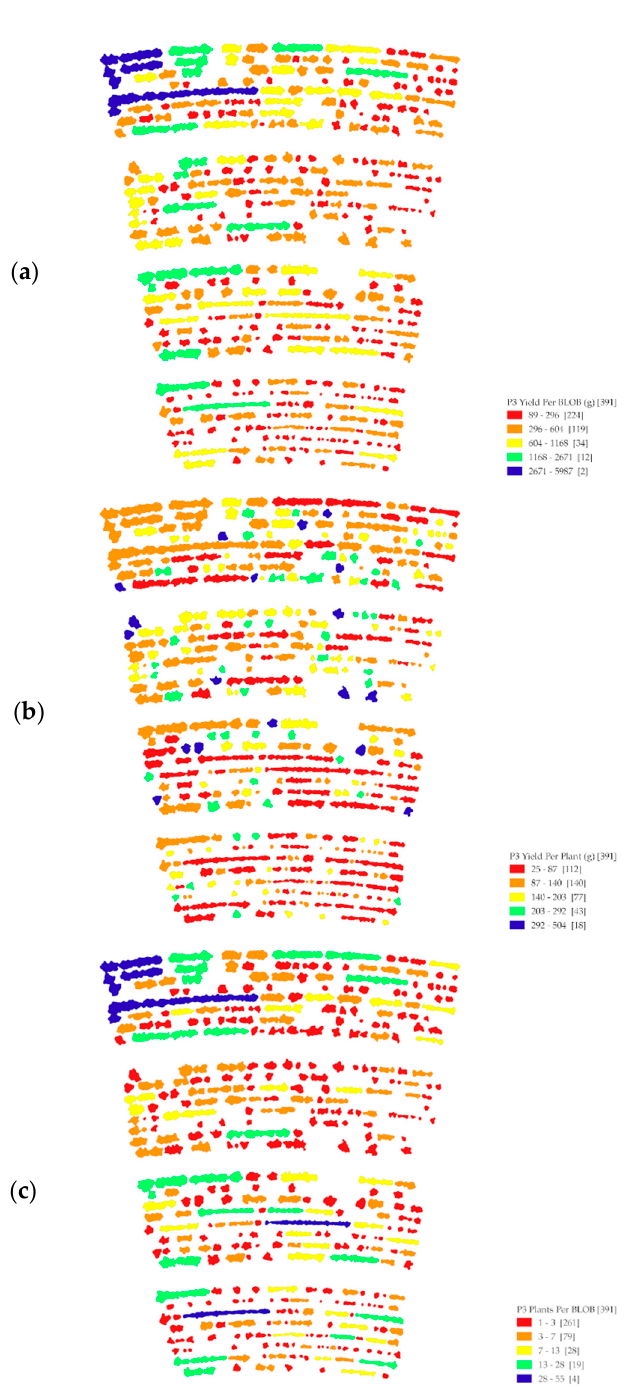
Figure 6. Binary large objects (BLOBs) mapped with color to indicate extracted plant characteristics. ( a ) Yield (g) per BLOB; ( b ) yield (g) per plant; ( c ) number of plants per BLOB.